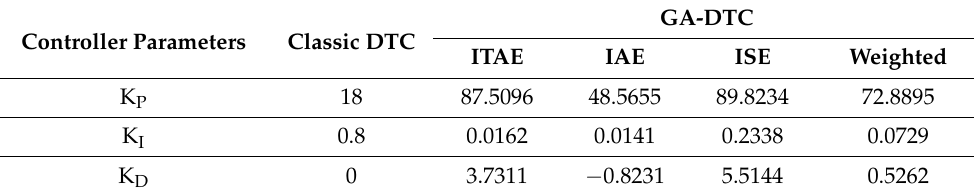
Table 4. Parameters of PID controller under DTC and